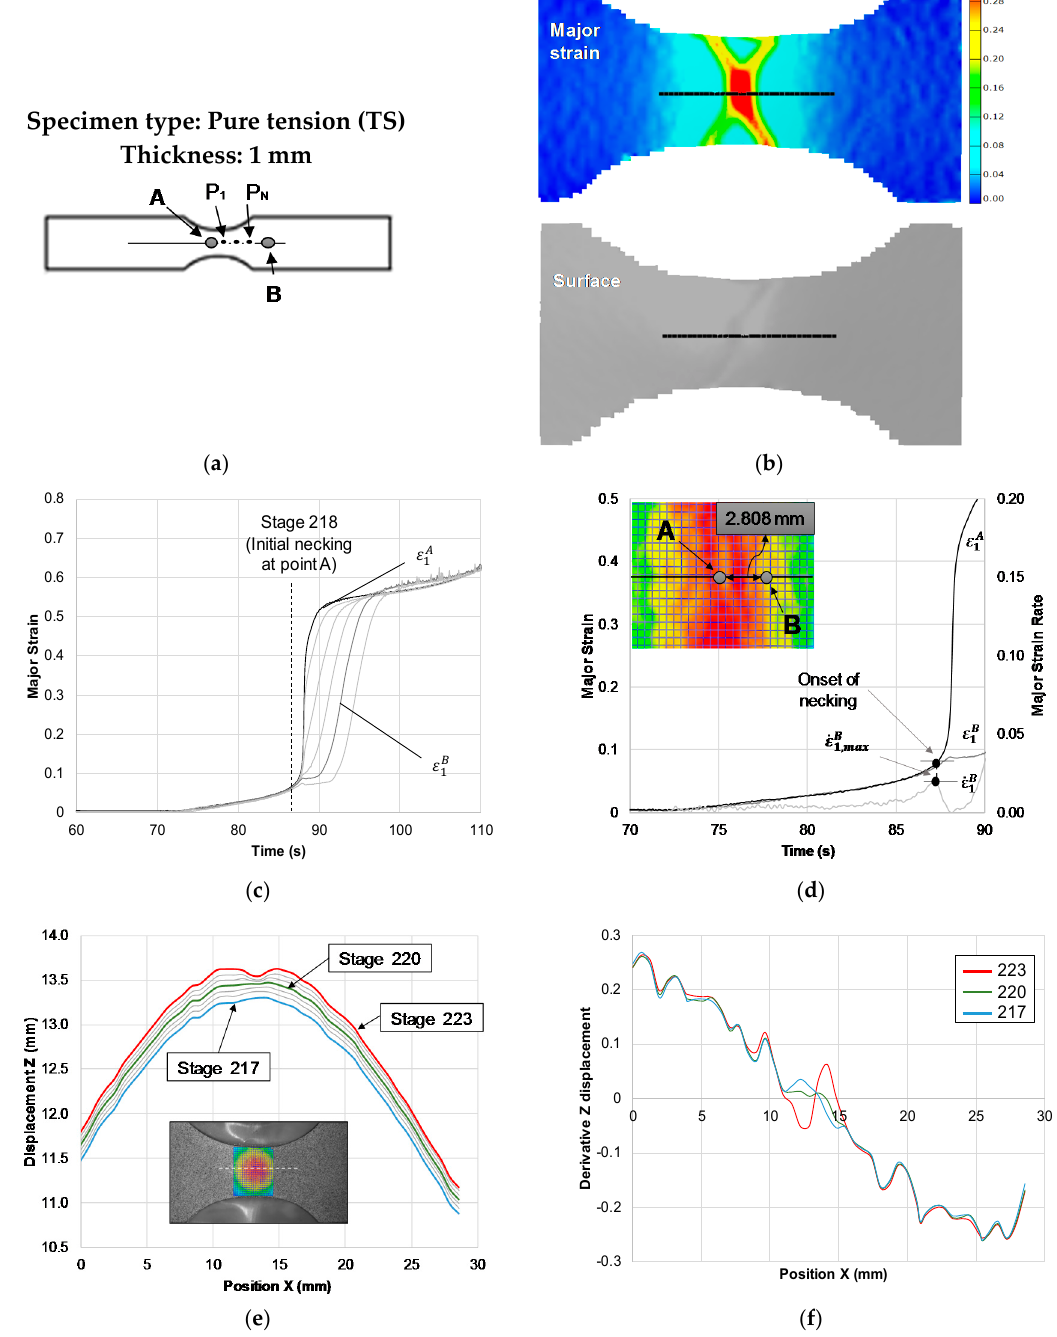
Figure 3. Application of the methodology to obtain the onset of necking strains for a tensile strain (TS) Nakajima specimen of PC with 1 mm of thickness. ( a ) The geometry of the specimens and identification of the section perpendicular to the failure region and selected points along its length. ( b ) Major strain (left) and surface shape (right) of the specimens’ failure area obtained by the DIC system. ( c ) Experimental time evolution of the major strain along the points of the selected section. ( d ) Time-dependent approach application. ( e ) Z-displacement along the selected section. ( f ) The spatial derivative of Z-displacement along the selected section.